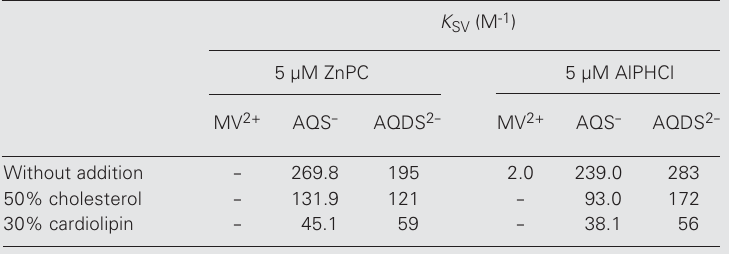
Table 2. Fluorescence quenching parameters of ZnPC and AlPHCl (5.0 µM) in DMPC liposomes in the presence and absence of additives at 25 º